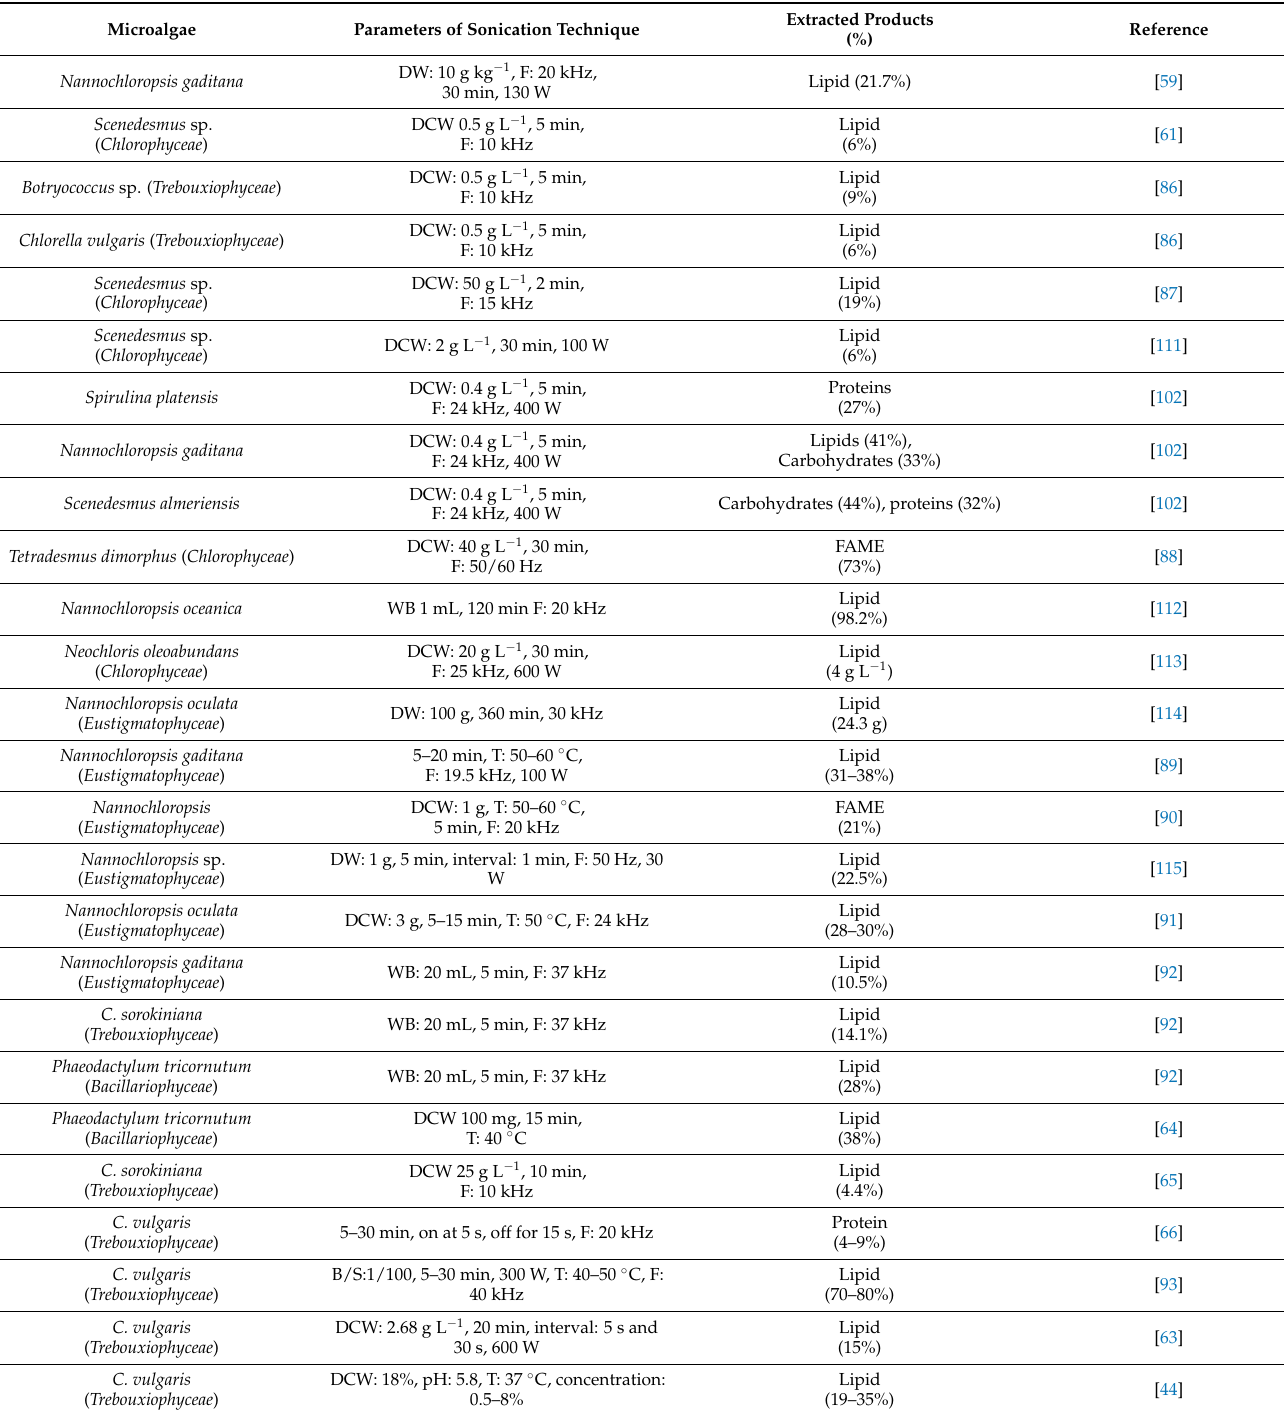
Table 3. Effects of the parameters of the ultrasonication technique for the cell disruption of various types of microalgae. DW: dry weight; DCW: dry cell weight; WB: wet biomass; T: temperature;